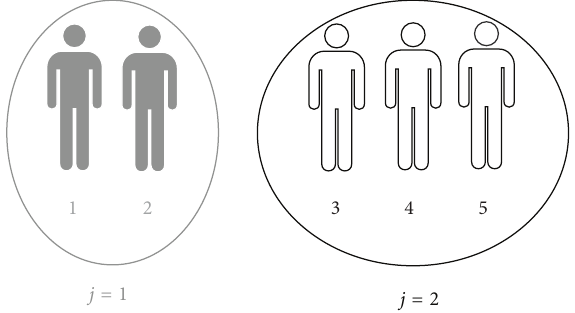
Figure 1: Schematic illustrating the definition of customers. The set of aggregate customers 𝐽 is composed of two elements, that is, 𝐽 = {1, 2} , and the set of individual customers is 𝐽 = {1, 2, 3, 4, 5} . The aggregate customer 1 includes individual customers 1 and 2, and the aggregate customer 2 stands for individual customers 3, 4, and 5. Thus, in this case the function 𝑗(𝑘) , mapping the individual customer 𝑘 ∈ 𝐽 to the aggregate customer, returns these values 𝑗(1) = 1 , 𝑗(2) = 1 , 𝑗(3) = 2 , 𝑗(4) = 2 , and 𝑗(5) = 2 , and the weights (multiplicities) assigned to aggregate customers are 𝑏 1 = 2 and 𝑏 2 = 3